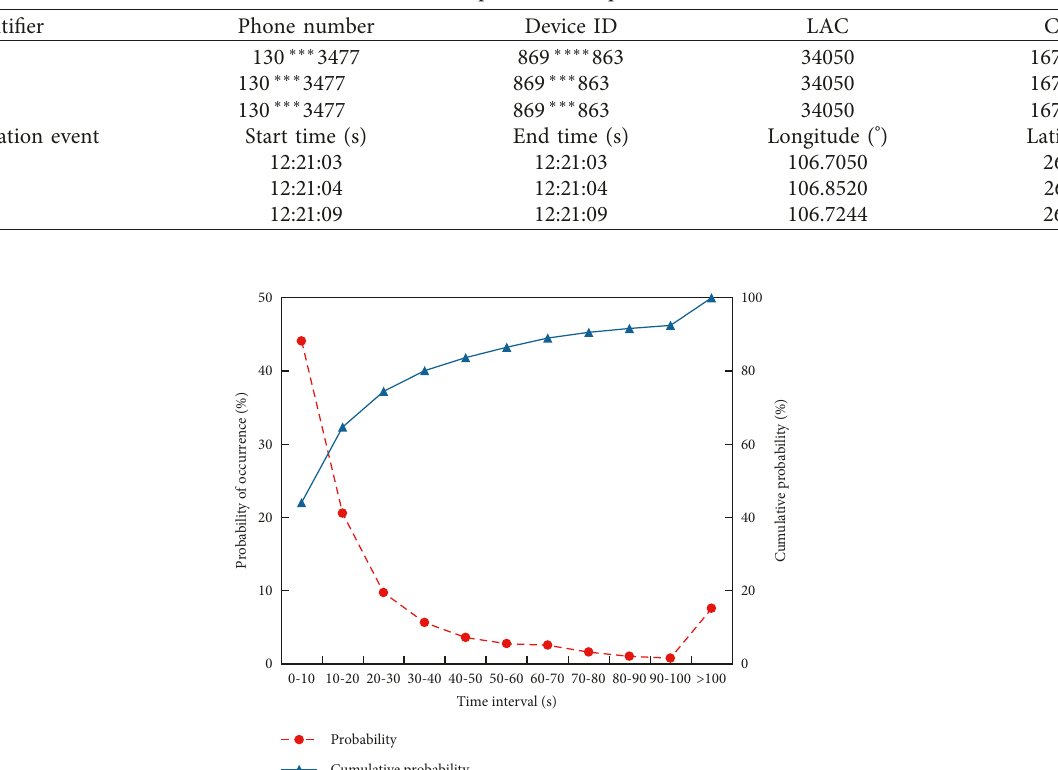
Table 1: An example of mobile phone data.